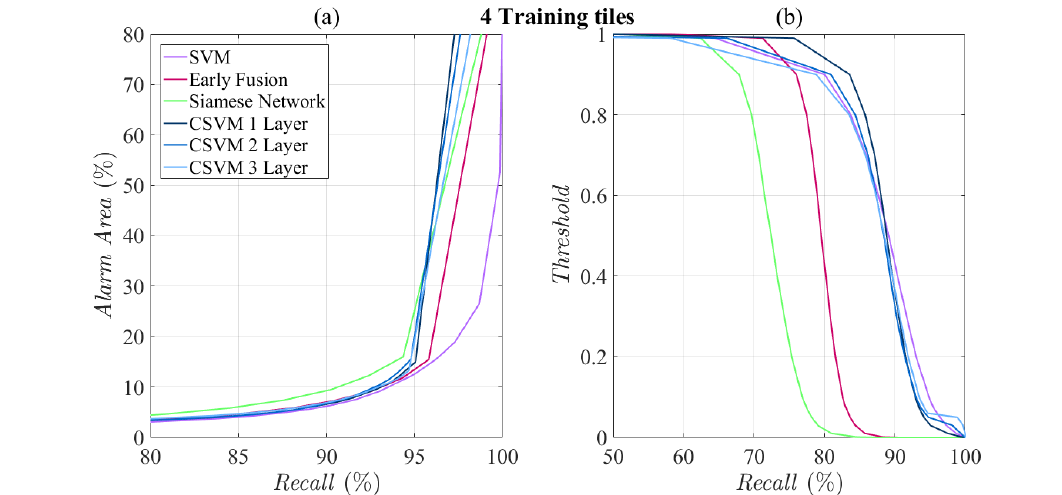
Figure 16. ( a ) Recall vs. Alarm Area (deforested area) for Amazon biome using four training tiles. ( b ) The recall values are obtained by threshold